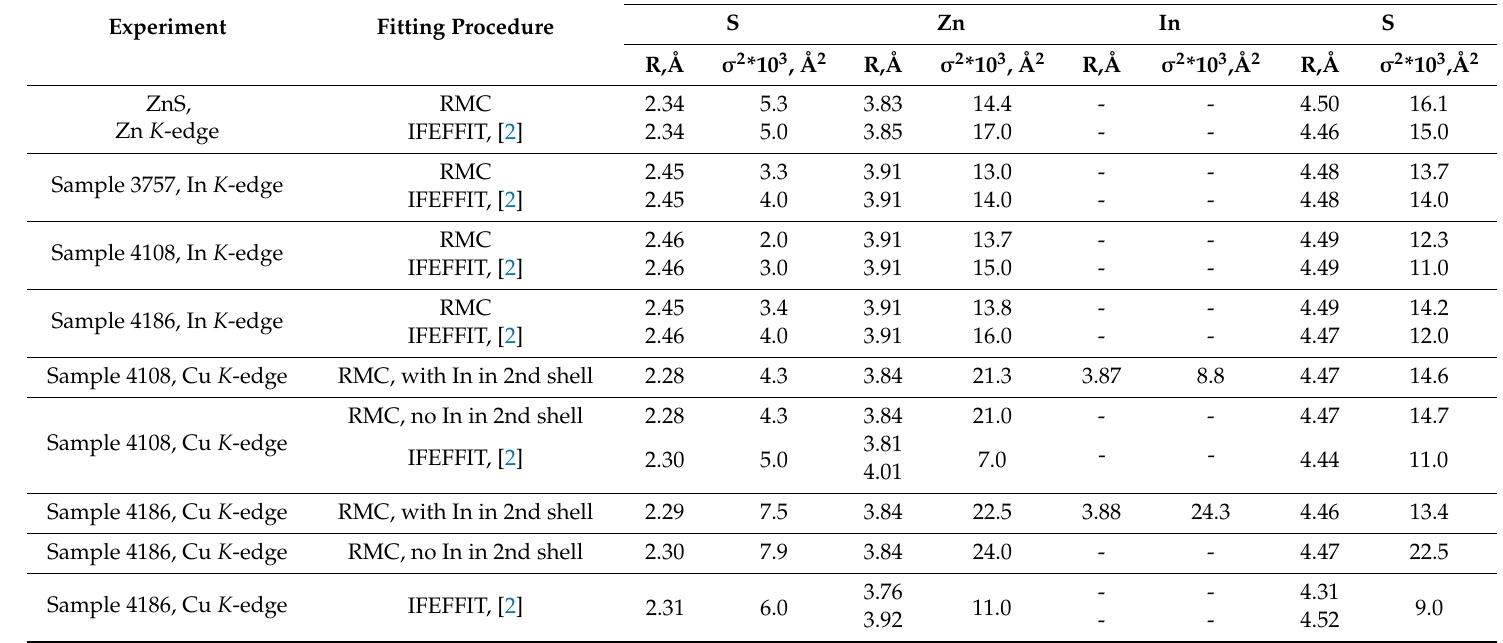
Table 2. Structural parameters derived from RMC-EXAFS fitting (all RDF peaks are fitted with one Gaussian function). Coordination numbers of sphalerite structure were fixed for all samples. Results of the present study (RMC) are compared with values derived by conventional EXAFS analysis performed using IFFEFIT software